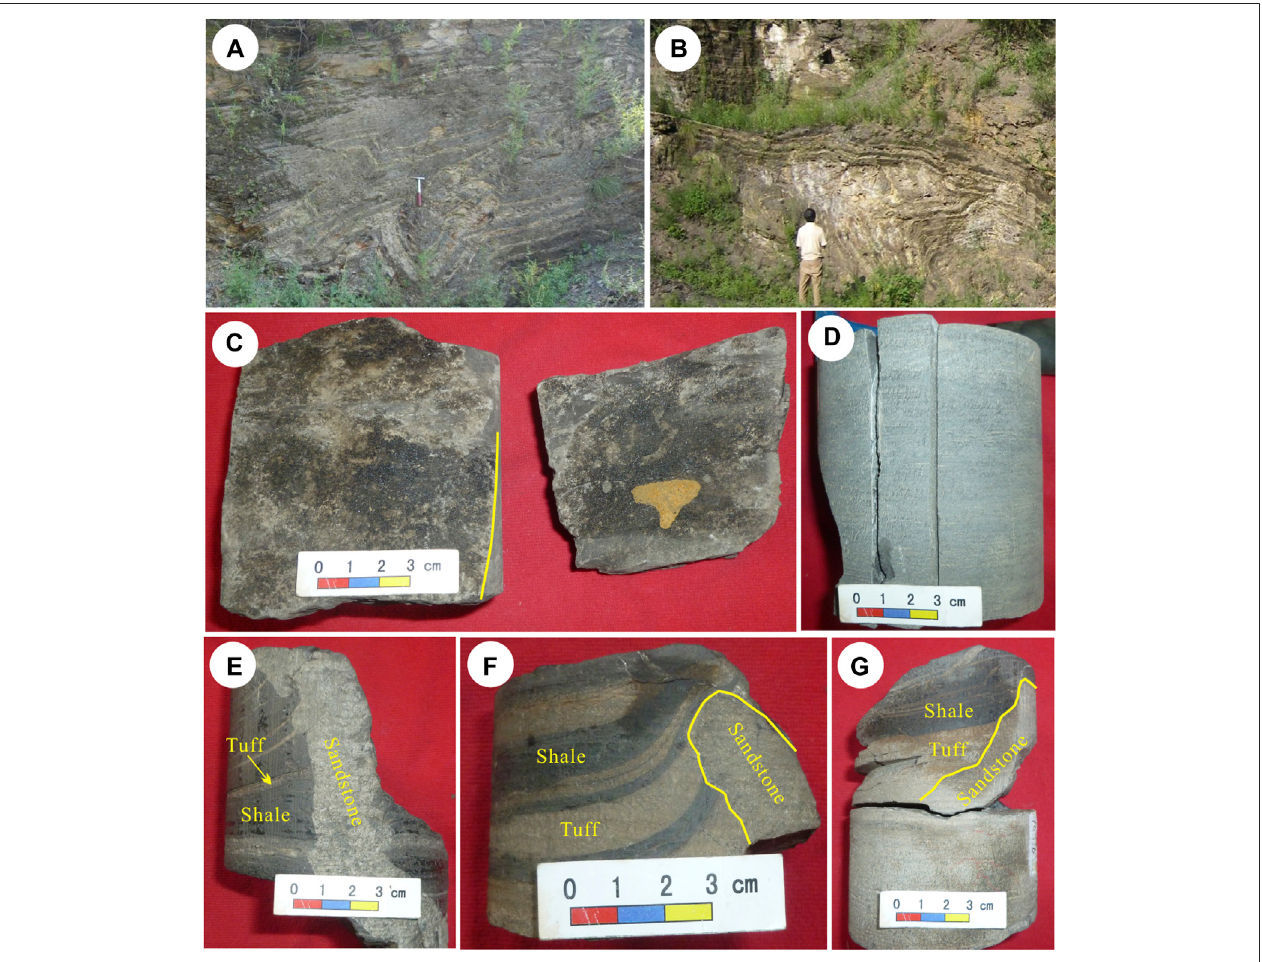
FIGURE 3 | Outcrop and core photographs of the Chang 7 Member in the Ordos Basin (A,B) Folds in the Chang 7 black shale in the west of Hejiafang section, Tongchuan(afterQiu, 2011); (C) High angle fracture with residual asphalt,Well Z119, 2241.30 m; (D) Vertical fractures, Well Z140, 1884.70 m; (E – G) Tuff intervals, and structural deformations caused by earthquake, Well W100, the depth is 1914.45 m, 1914.73 and 1914.95 m, respectively.